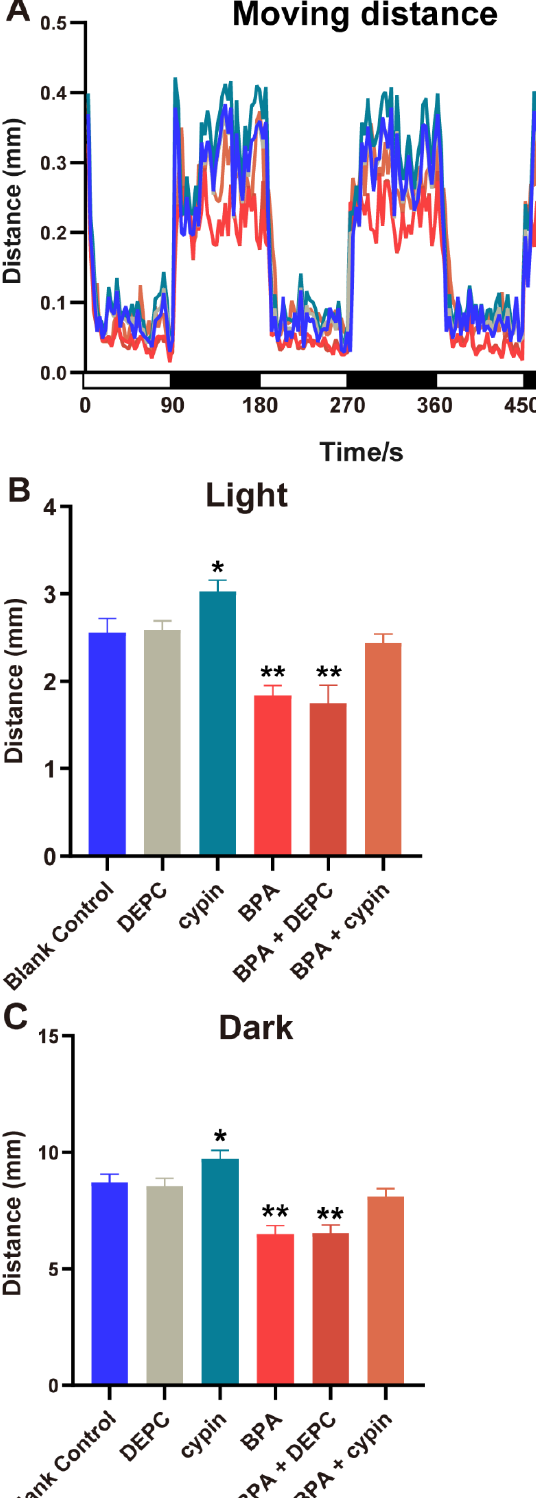
Figure 10. Effects of exposure to BPA on locomotor behavior under light-dark cycle stimulation of zebrafish embryos after microinjection of cypin mRNA. ( A ) The trend of distance. ( B , C ) The analysis results of the trend of the distance. Abscissa white for light, black for darkness. Data are the mean ± SD (n = 24 in each concentration). *, significant from blank control, p < 0.01; **, significant from blank control, p <